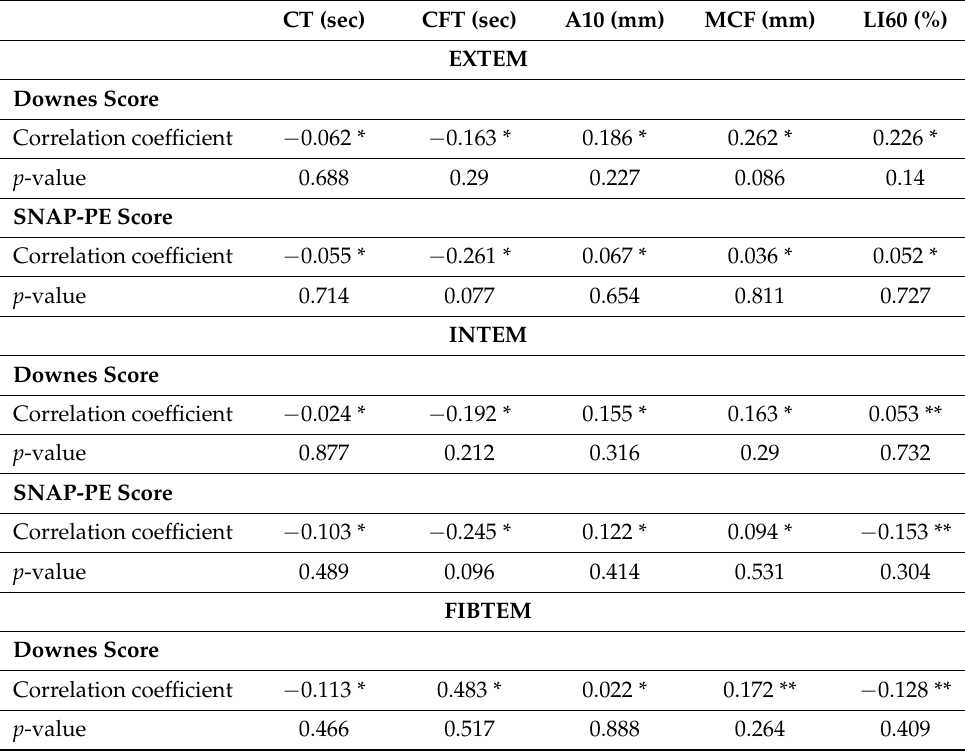
Table 5. Downes Score and SNAP-PE Score in correlation with alterations in ROTEM